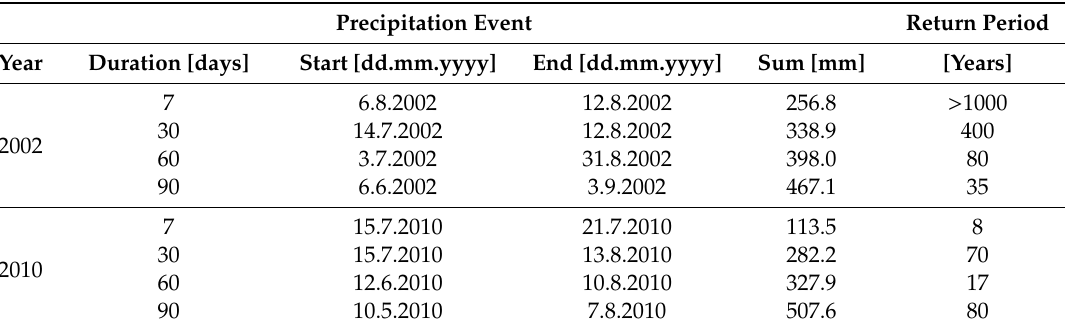
Table 2. Extreme precipitation events.